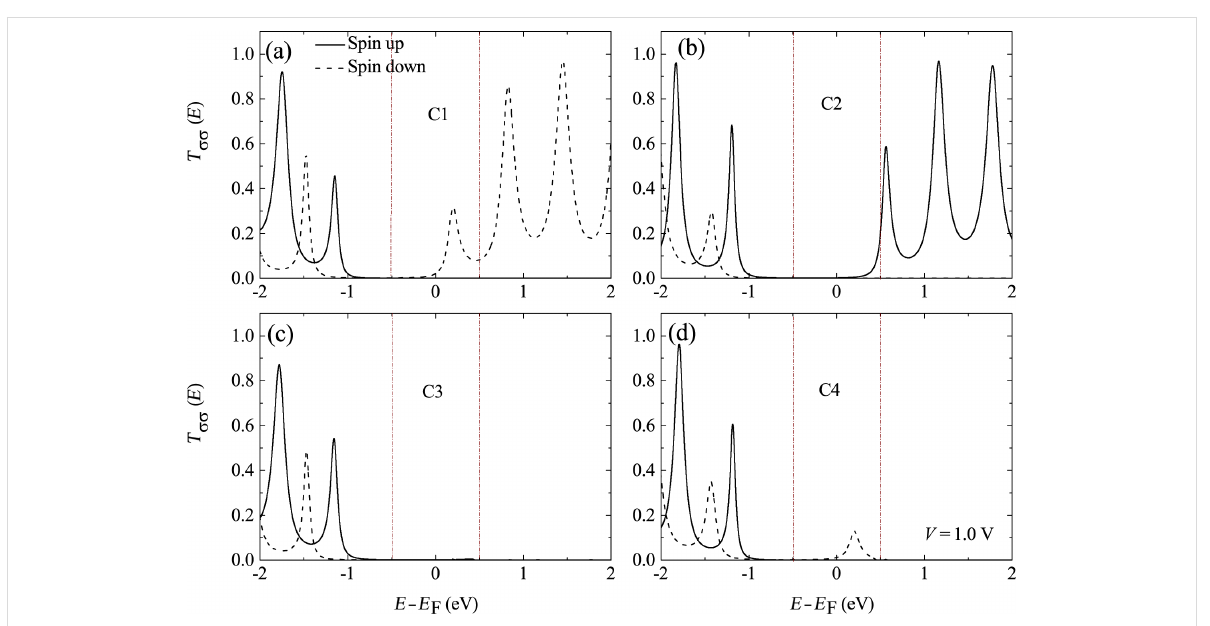
Figure 7: Spin-dependent transmission T σσ ( E ) as a function of energy close to the Fermi energy for the four magnetization configurations. Panels (a–d) correspond to configurations C1–C4, respectively. The bias voltage is V = 1.0 V. Reproduced with permission from [32], copyright 2014 AIP Publishing.